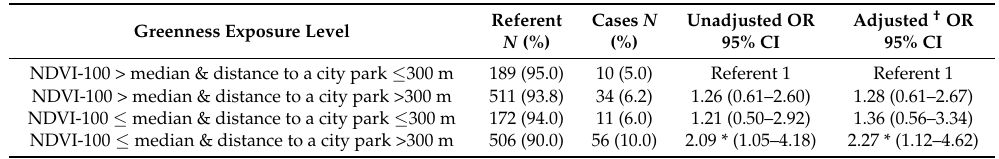
Table 3. Joint effect of greenness cover level and home distance to the nearest city park on the risk of children’s overweight/obesity (stratified analysis).